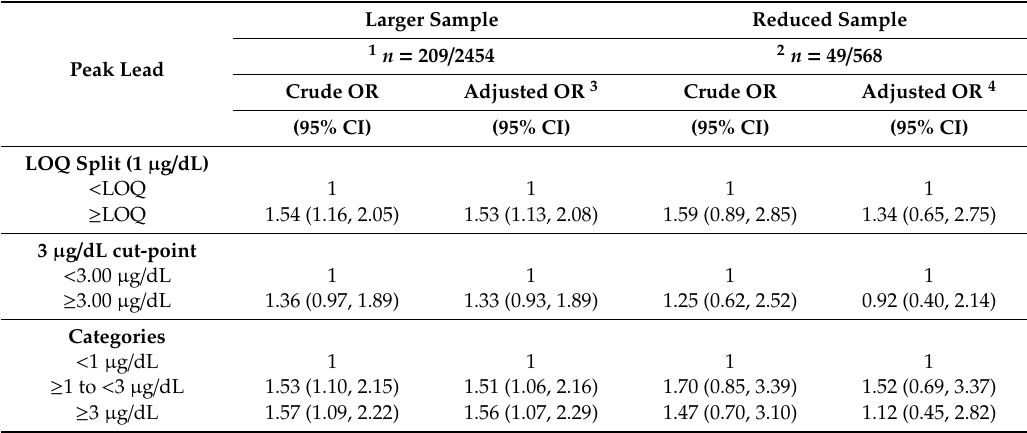
Table 4. Crude and adjusted risk estimates of influenza comparing cases with controls by peak blood lead concentrations.